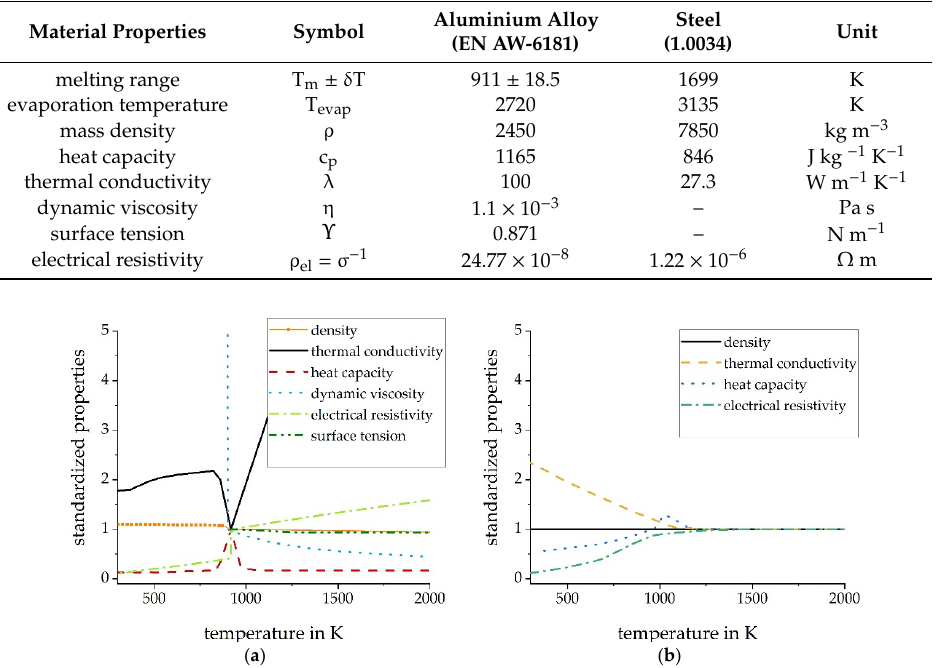
Table 1. Material properties of steel [14,15] and aluminium alloy [16,17] at melt temperature. Material Properties